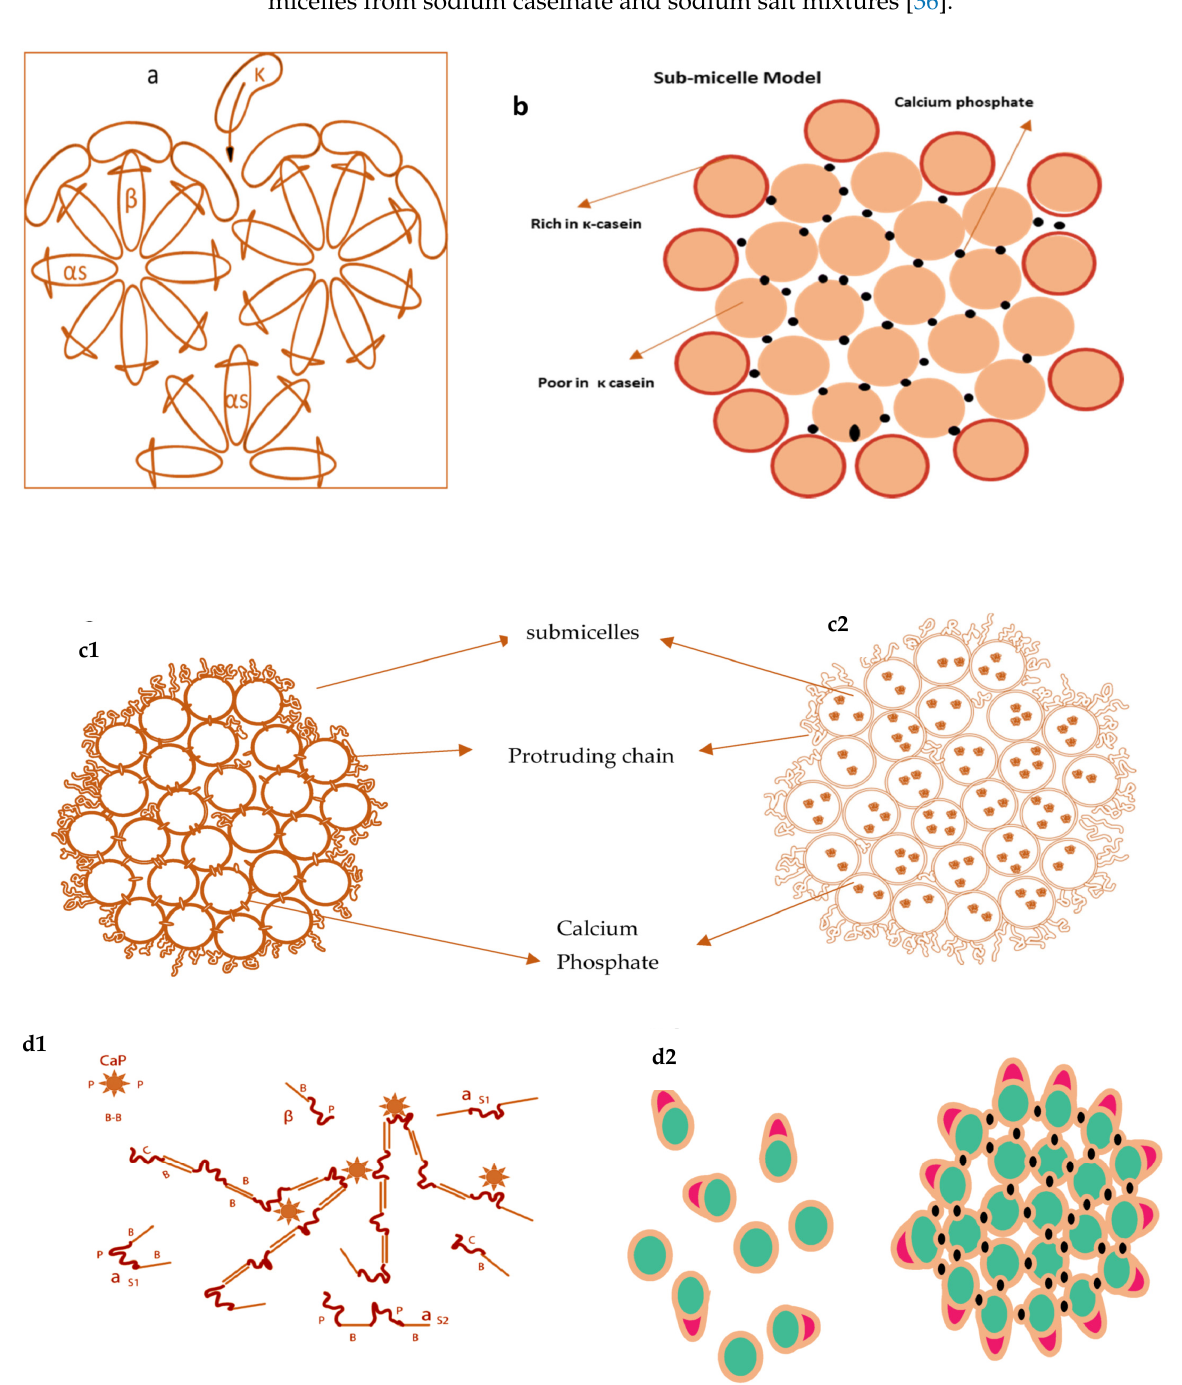
Figure 2. Casein micelles model by Waugh 1958 ( a ), models by Schmidt in 1982 ( b ), model proposed by Walstra in 1990 ( c1 ) & 1999 ( c2 ), (differs in calcium phosphate location), Dual binding model by Horne (2003) ( d1 ) and interpretation of Schmidt’s model in 2005 ( d2 ).